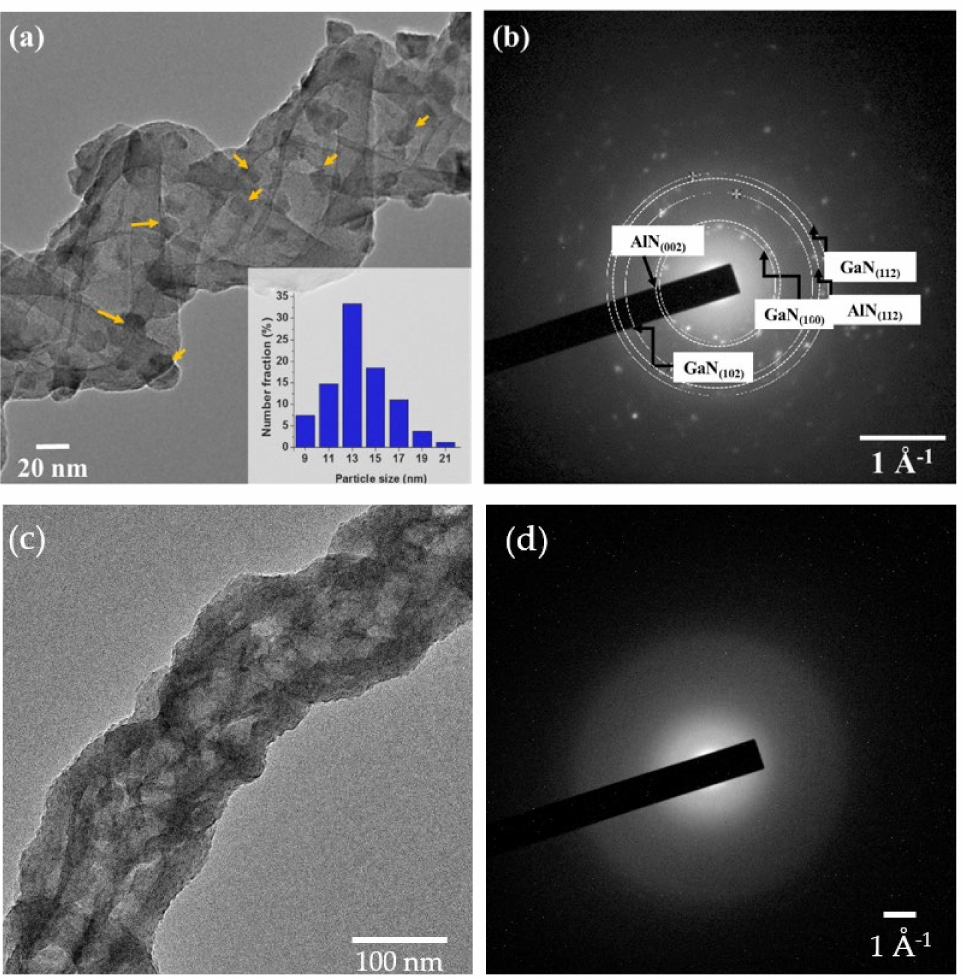
Figure 7. ( a ) Transmission Electron Microscopy (TEM) micrograph of a 50 cycle GaN coating with an Al 2 O 3 / AlN bu ff er layer on a silica NS. The yellow arrows indicate GaN nanoparticles. The inset is the GaN nanoparticle size distribution, ( b ) Selected Area Electron Di ff raction (SAED) pattern obtained on the region consisting of rings corresponding to GaN and the AlN bu ff er layer, ( c ) a TEM micrograph of a 50 cycle GaN coating on a silica NS and ( d ) the corresponding SAED pattern, where di ff raction spots are not